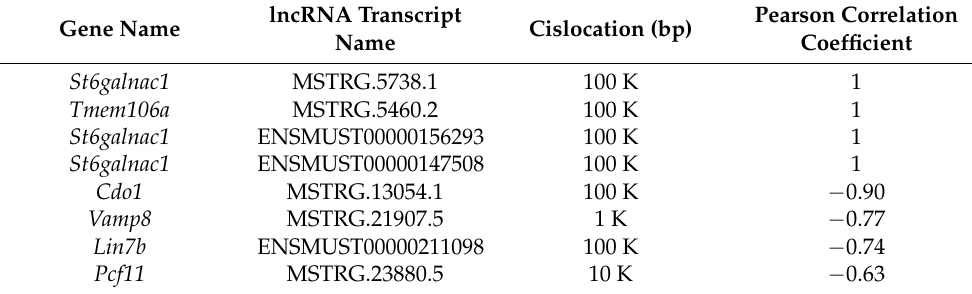
Figure 6. GO and KEGG analysis of differentially expressed lncRNAs. ( A ) Histogram of GO enrichment of DE lncRNAs. ( B ) Scatter plot of GO enrichment of DE lncRNAs. ( C ) Scatter plot of KEGG enrichment of DE lncRNAs. Table 1. Differentially expressed lncRNA-gene pairs between PPV23 and control group.